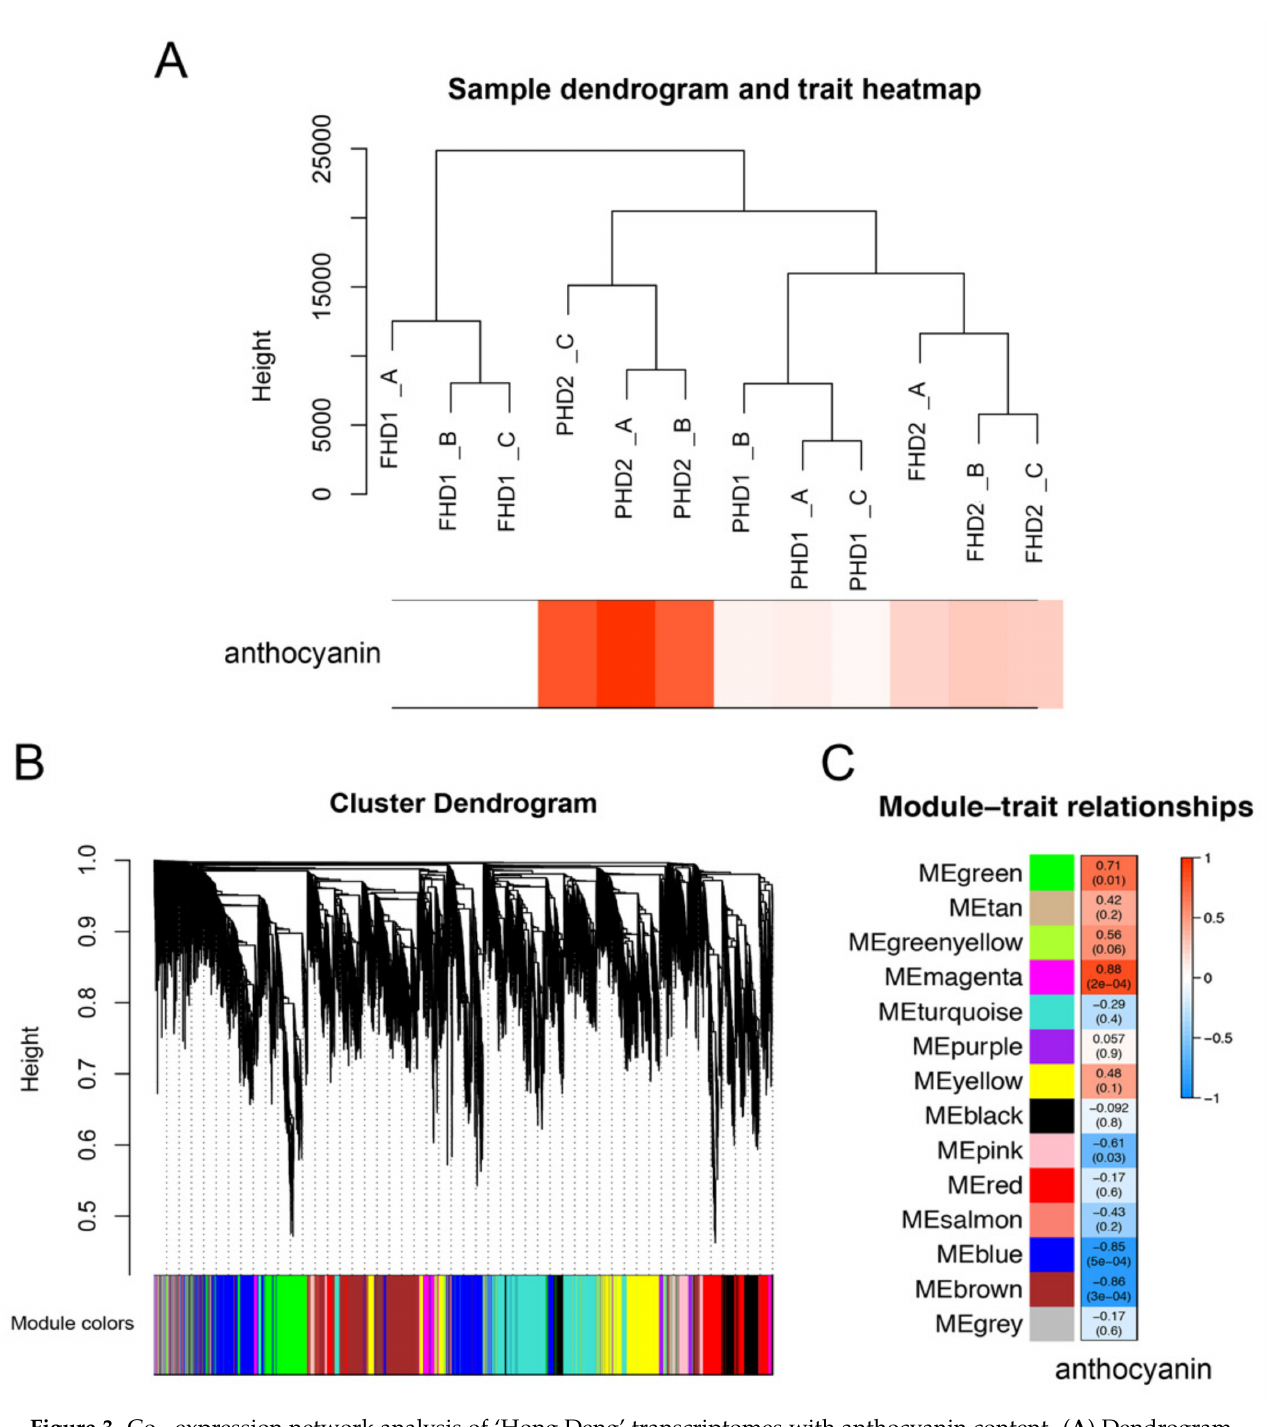
Figure 3. Co − expression network analysis of ‘Hong Deng’ transcriptomes with anthocyanin content. ( A ) Dendrogram plot of samples and heatmap with anthocyanin content. ( B ) Hierarchical cluster tree with color annotation showing 14 co − expression modules for co − expressed genes. ( C ) Module − color correlations and corresponding p -values. The left panel shows 14 modules, and the right color scale shows the modules’ correlations from − 1 to